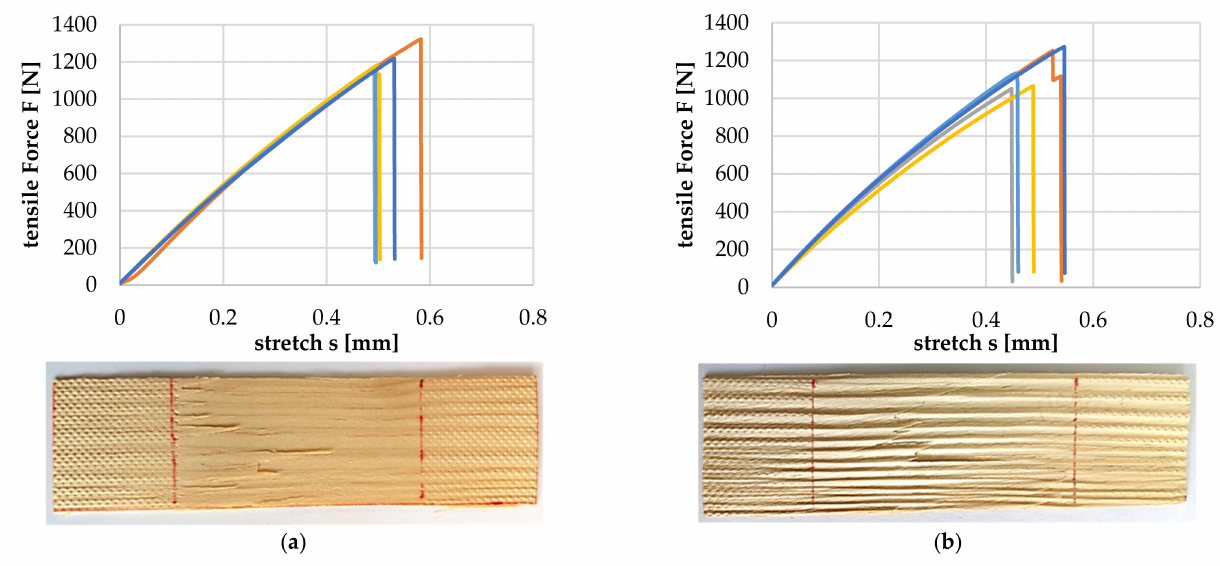
Figure 20. Comparison of tensile test of uncompressed ( a ) and compressed wood particles ( b ). The average tolerable tensile force for the uncompressed wood particles was 1204.4 (+116.4/ − 53.4) N, and for the compressed wood particles, it was 1153.6 (+117.4/ − 102.6)